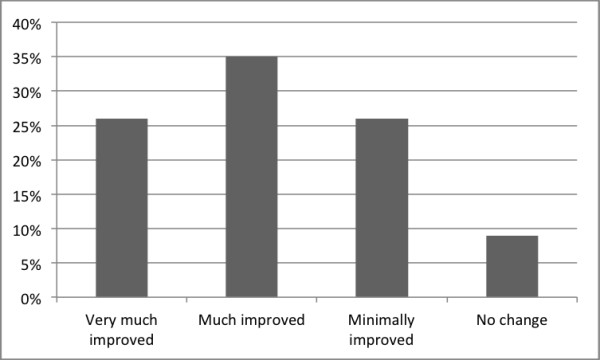
CGI improvements.